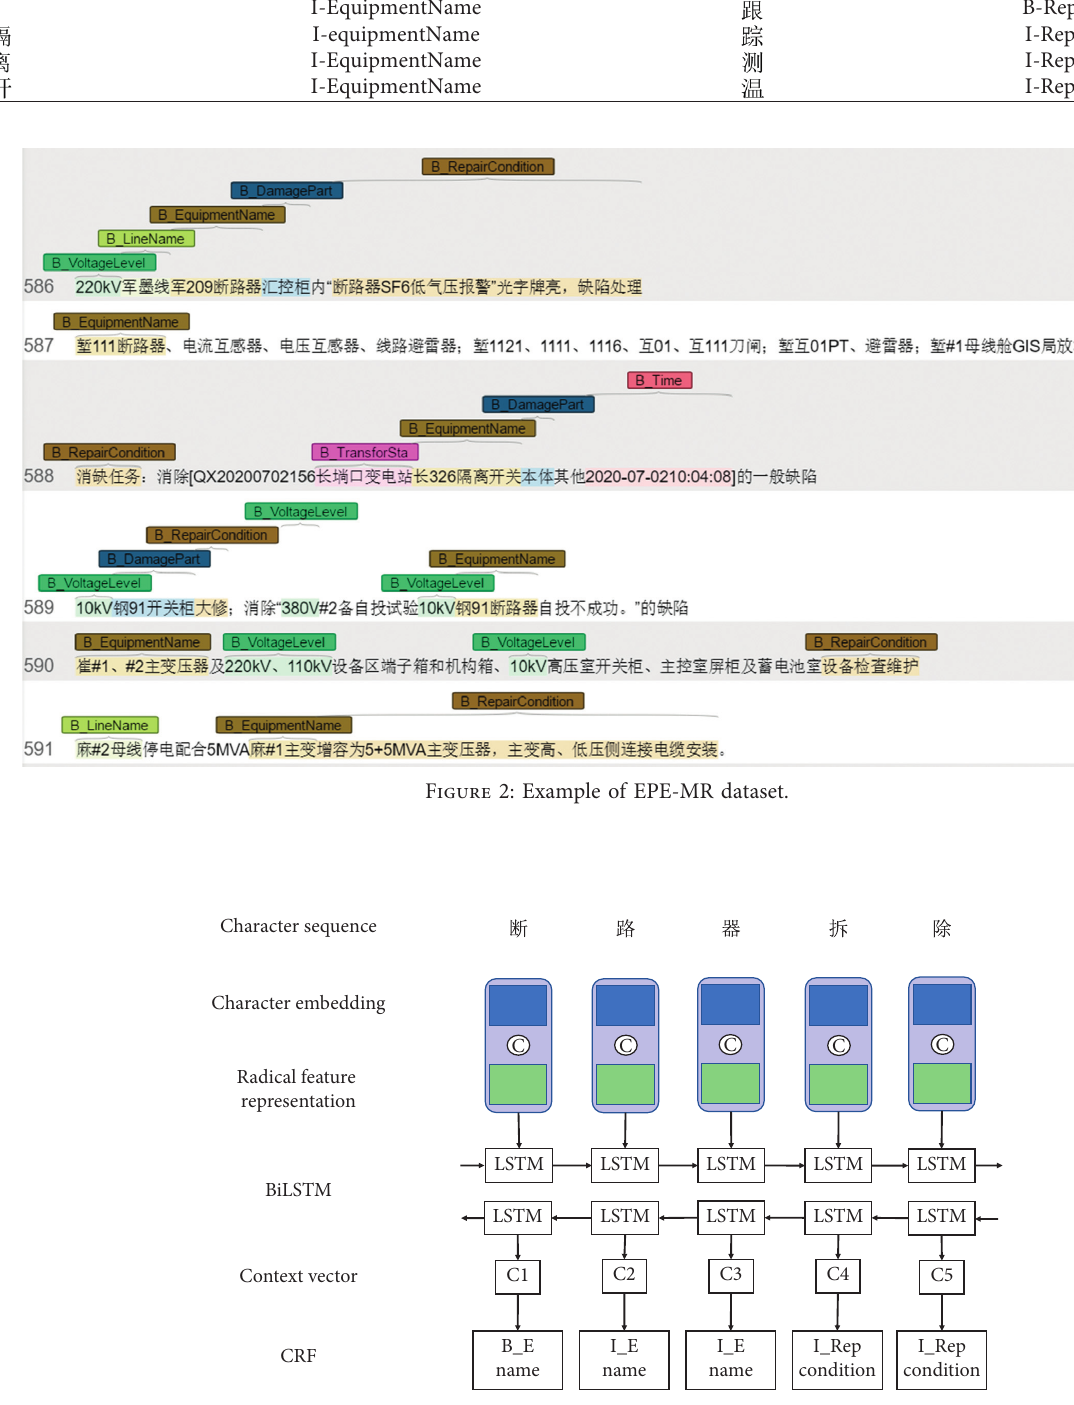
Figure 3: The framework of the proposed PMTFF model ( means breaker